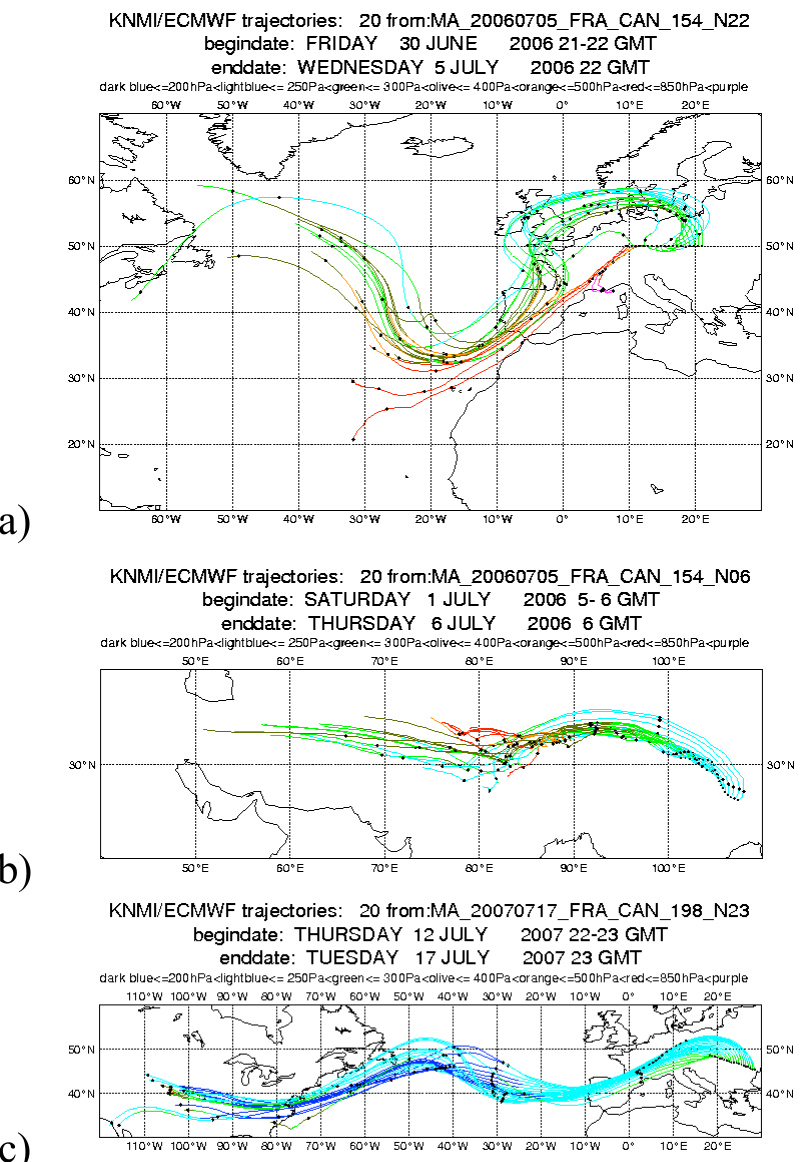
Fig. 9. KNMI/ECMWF 5-day air mass back-trajectories. Coordinates and dates of arrival points correspond to plumes sampled along the 2006 and 2007 July flights (Fig.